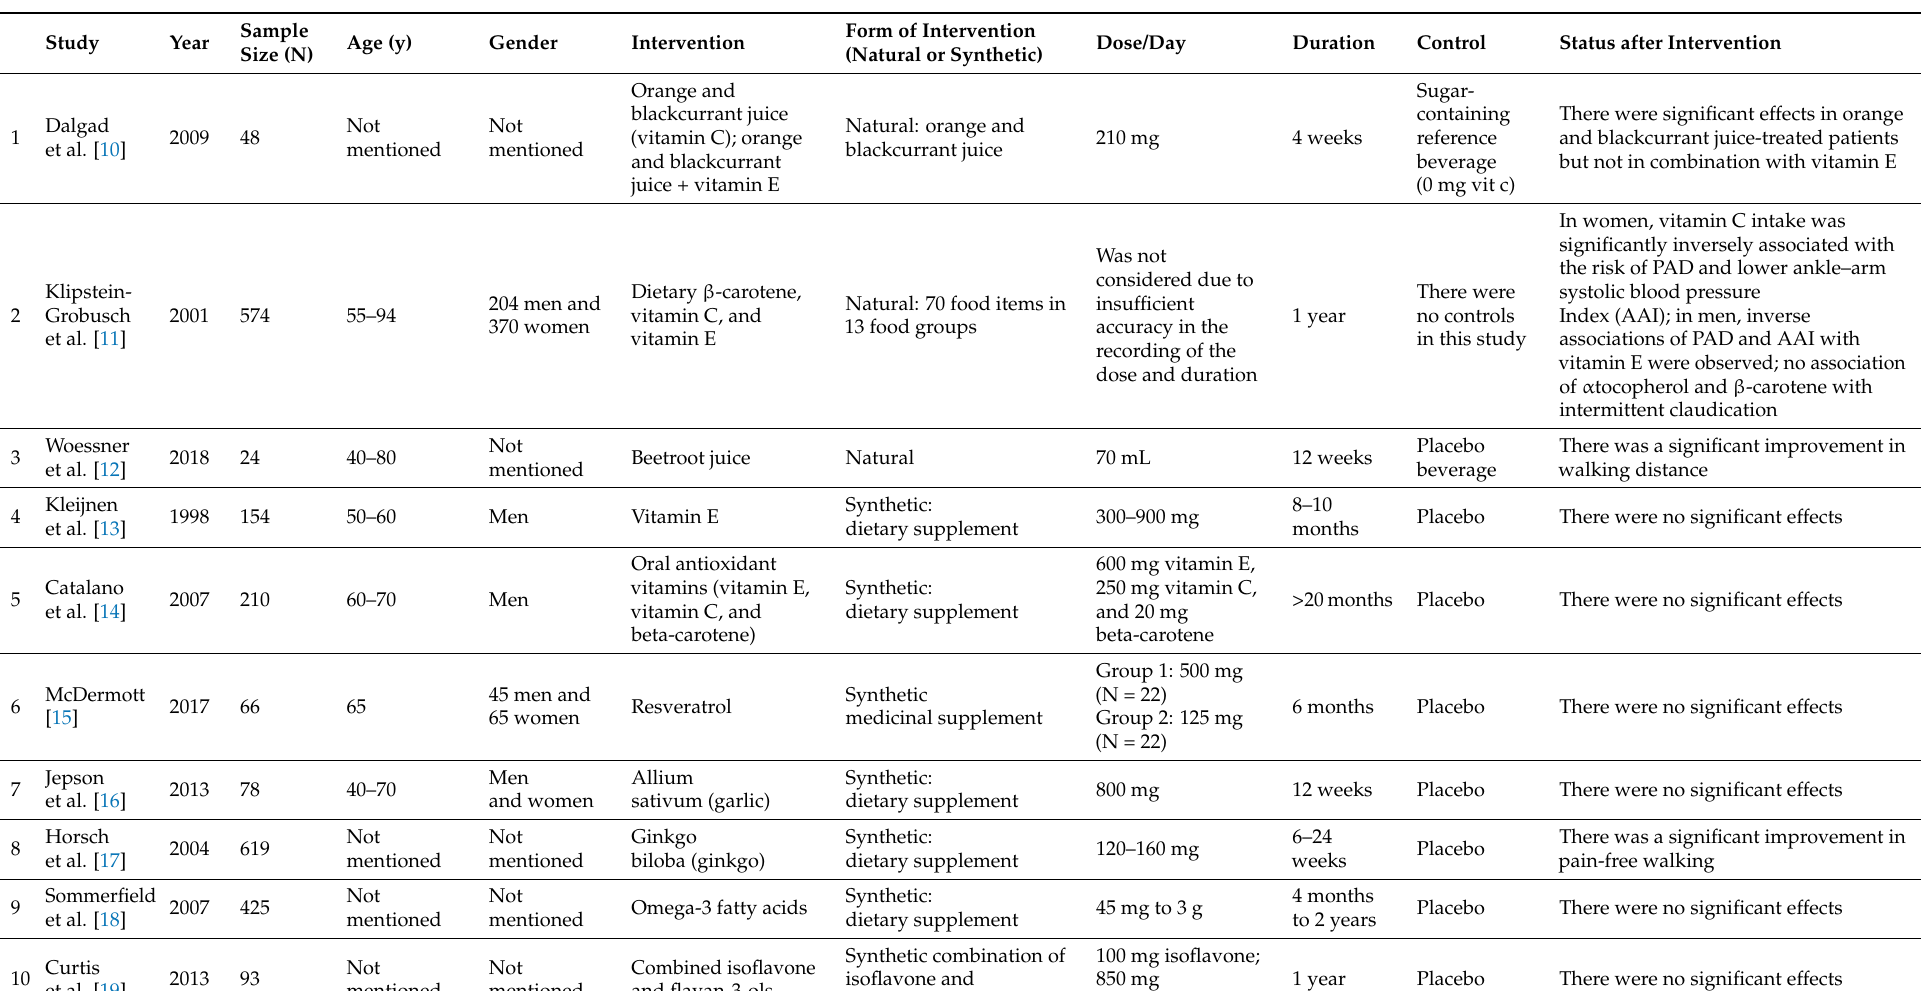
Table 3. The summarized results of 18 articles that fulfilled the inclusion